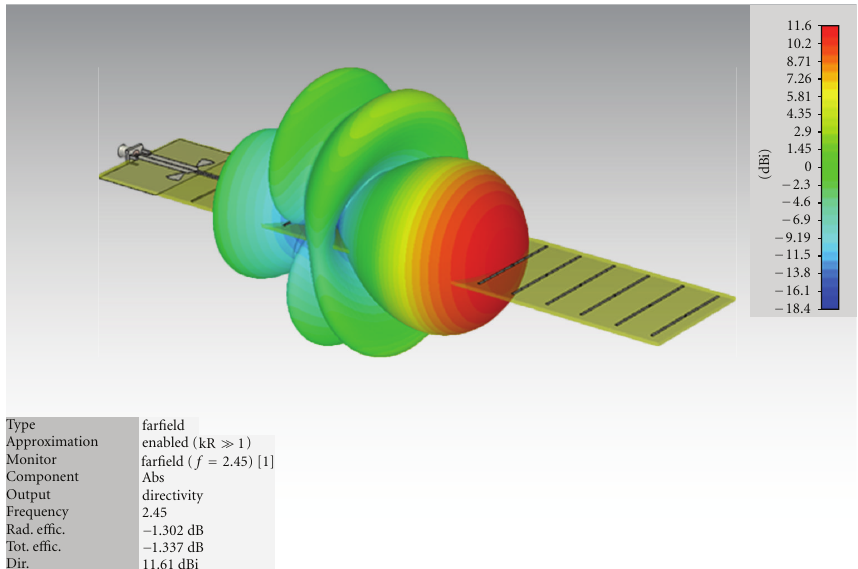
Figure 31: Radiation pattern computed with a full wave simulation (CST) at 2.45GHz. The directivity is 11.6dB.